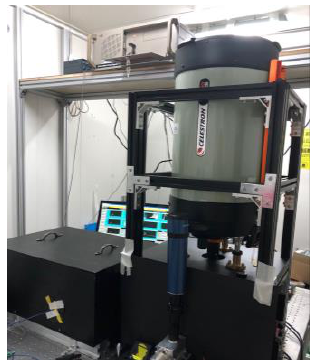
Fig 4 A receive module schematic diagram of